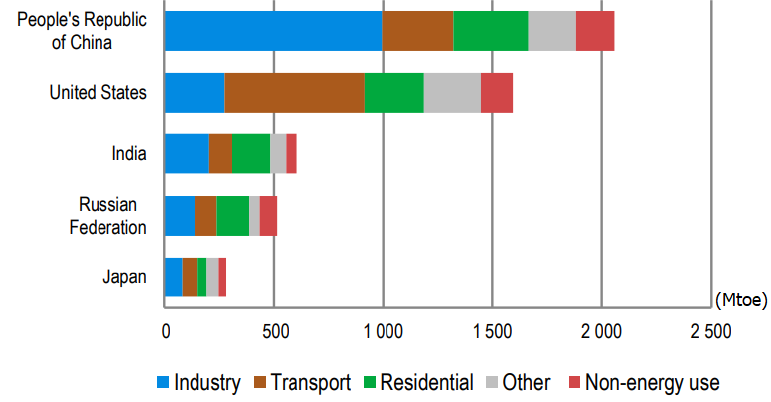
Figure 3. Top five countries by total final energy consumption